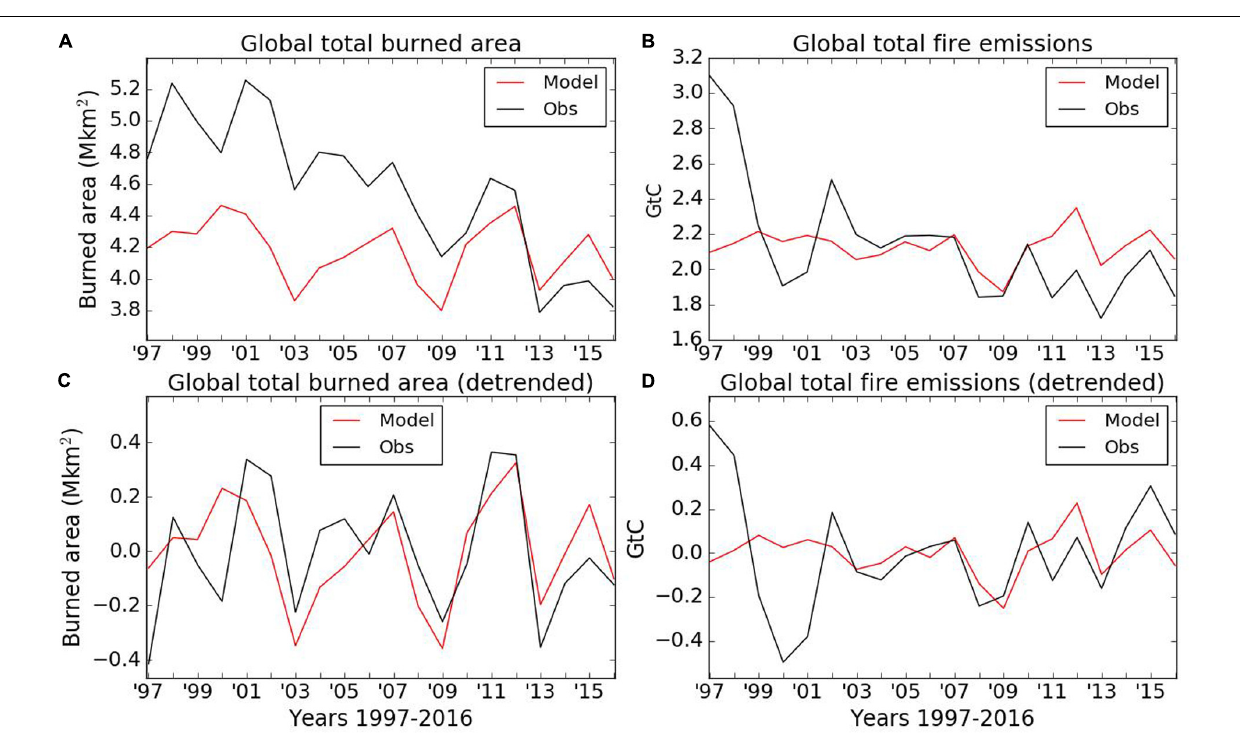
FIGURE 2 | Burned area (left column) and emitted carbon from fires (right column) simulated by JULES-INFERNO (red) with GFED observations (black), 1997–2016. Top plots show total burned area, bottom plots show de-trended data. Burned area (left column A and C ) and emitted carbon from fires (right column B and D ) simulated by JULES-INFERNO (red) with GFED observations (black) 1997-2016. Top plots (A,B) show total burned area, bottom plots (C,D) show de-trended